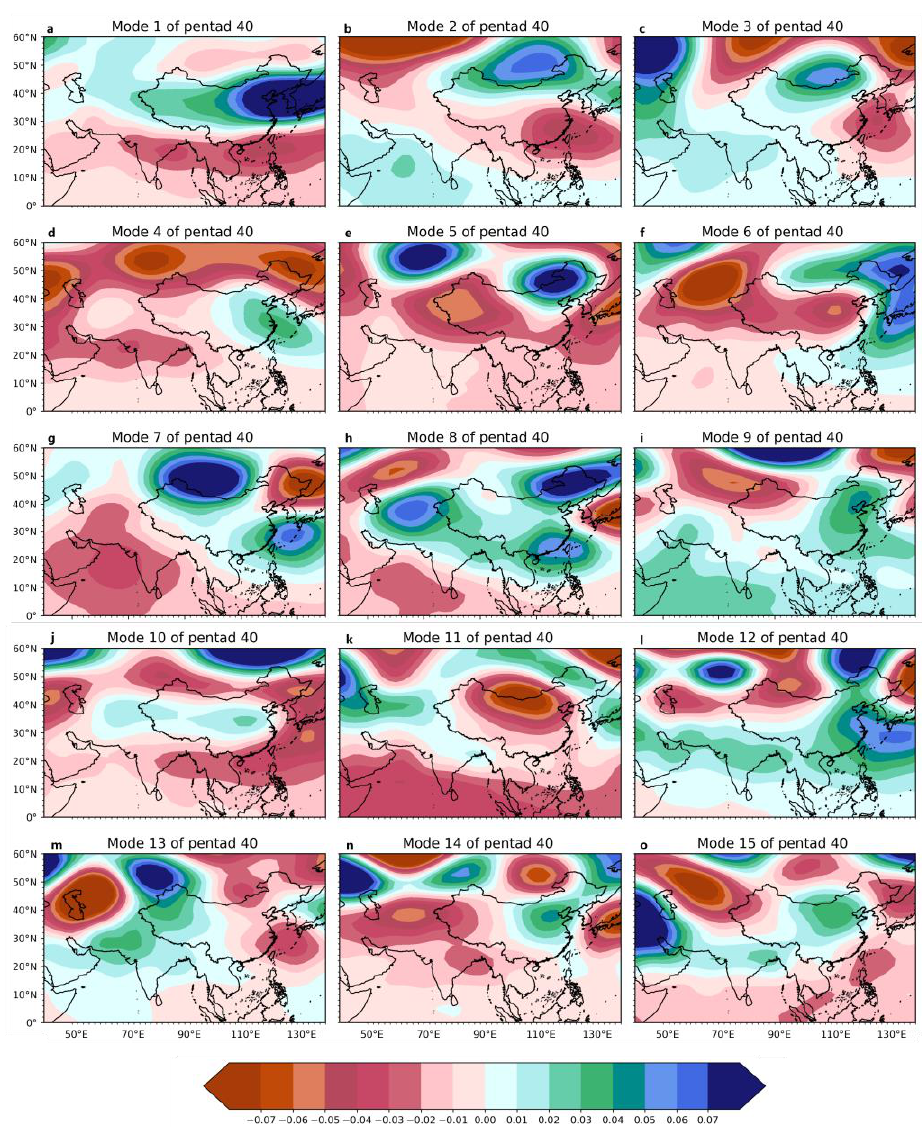
Figure 3. Right field of the first 15 modes ( a – o , respectively) of the SVD decomposition corresponding to Figure 2 (anomaly distribution of the pentad Z500 in the fourth pentad of July).